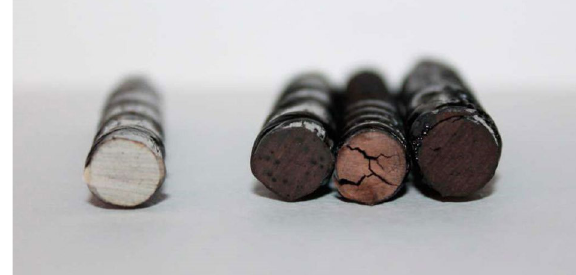
Fig. 6. Cross-section of specimens after exposure to high temperature (300 °C) for 30